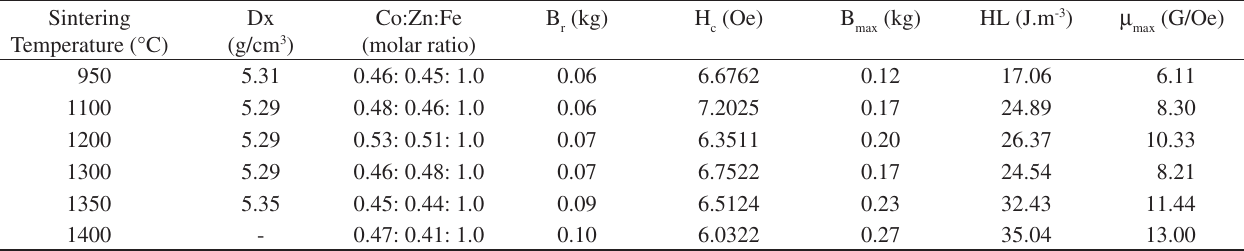
Table 2. Summary of properties of cobalt-zinc ferrites sintered at different temperatures.